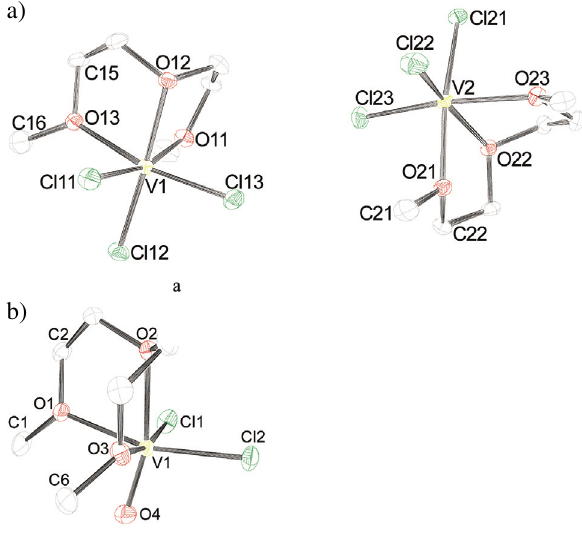
(diglyme) ] in green. 11 Hydrogen 3